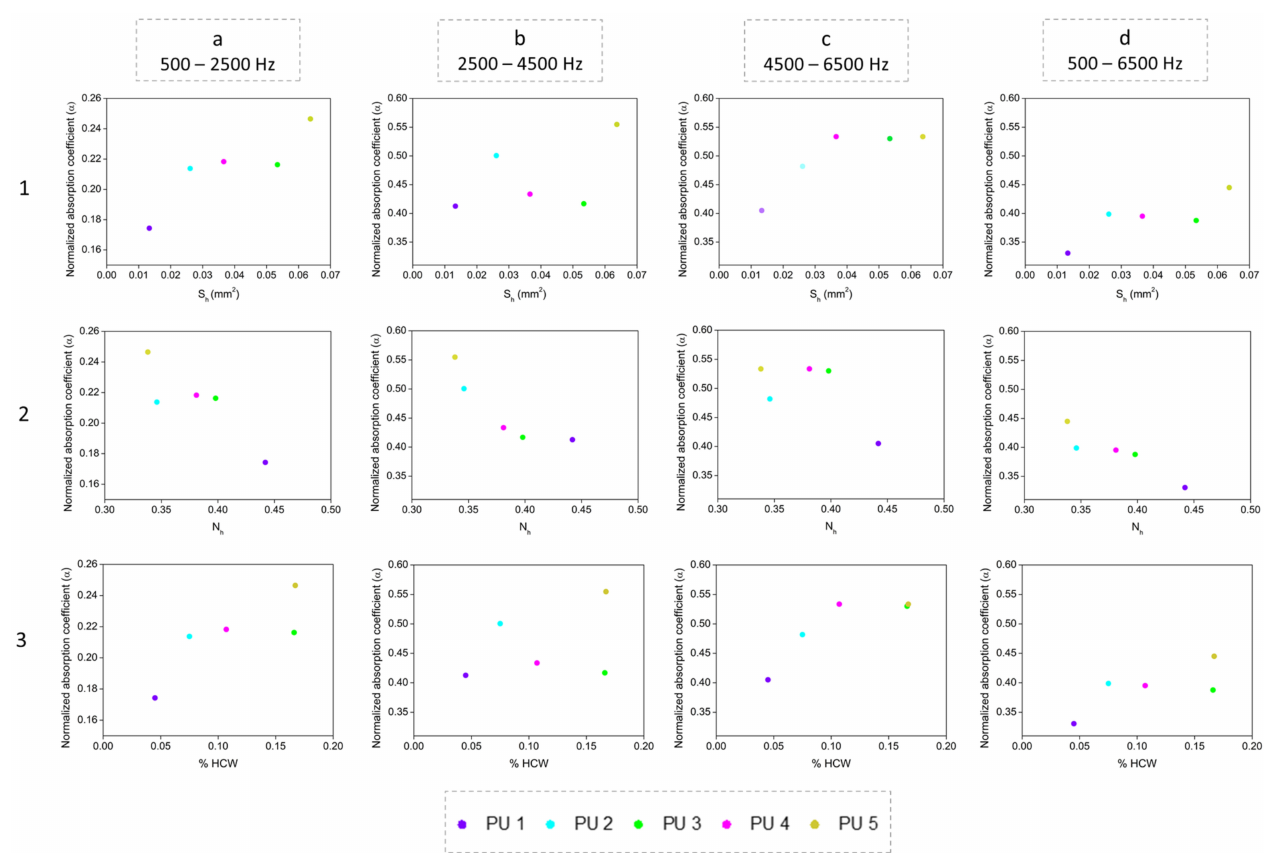
Figure 7. Relationship between surface hole S h (first row), number of holes N h (second row) and percentage of holes’ area on the cell walls %HCW (third row) with the normalized absorption coefficient at 500–2500 Hz (column ( a )), 2500–4500 Hz (column ( b )), 4500–6500 Hz (column ( c )) and the complete range 500–6500 Hz (column ( d )).